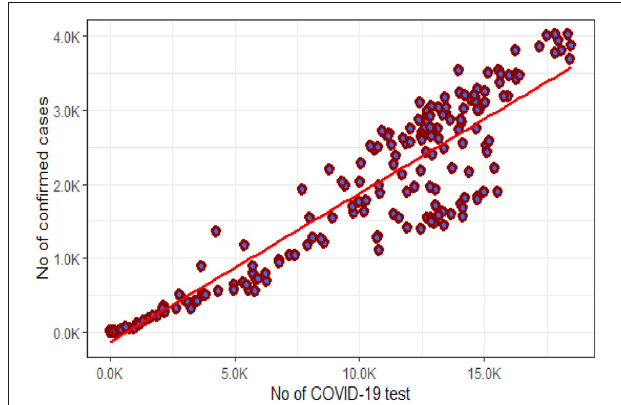
FIGURE 8 | Association between number of COVID-19 tests and confirmed cases in Bangladesh.